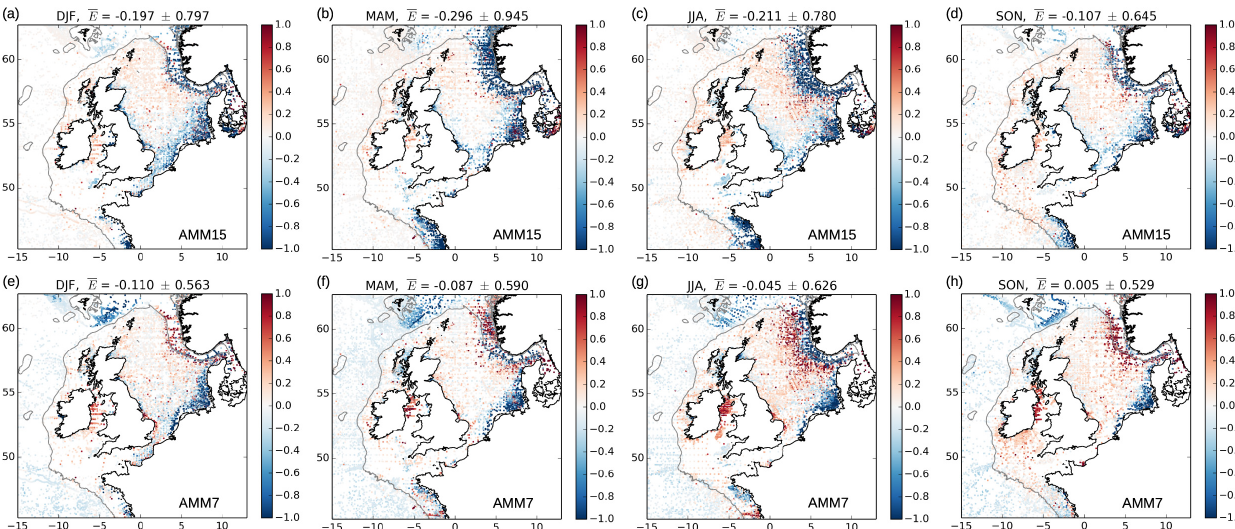
Figure 4. Mean seasonal SSS anomalies for model minus observations. Observations used are monthly mean EN4 profiles (Good et al., 2013). Upper panels (a–d) show anomalies for AMM15-EN4, lower panels (e–h) show anomalies for AMM7-EN4. All panels show monthly anomalies averaged over the period 1991–2010. Mean errors ( E ) are calculated for the AMM15 domain region (excluding the wider AMM7 domain). Grey contour shows the 200m isobath to indicate the limit of the continental